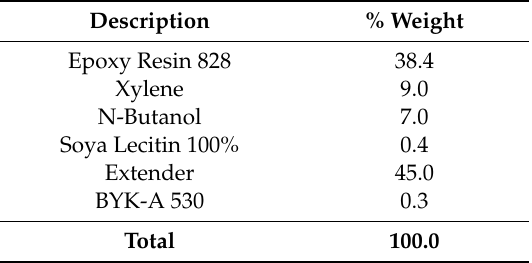
Table 2. Example of formulation for component